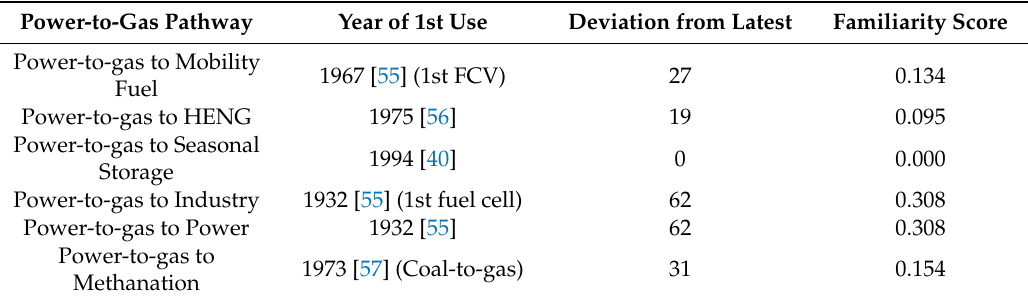
Table 11. Year of First Use for power-to-gas